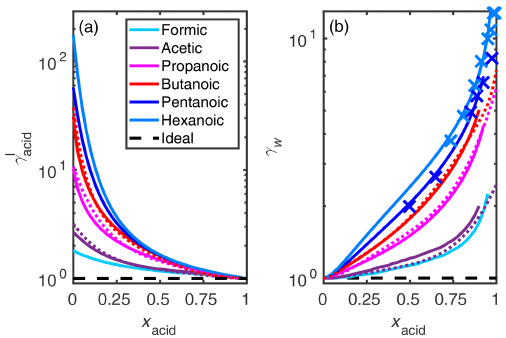
Figure 4. Activity coefficients ( γ I ) of (a) monocarboxylic acids and (b) water in all mixing states of the binary aqueous solutions, at 298.15K. The solid lines represent activity coefficient estimates us- ing COSMO-RS-DARE, dotted lines are calculated from the equa- tions fitted to experiments by Hansen et al. (1955), and the mark- ers are the experimental points from the same study. For the stud- ied acids with finite aqueous solubilities at 298.15K (pentanoic and hexanoic acid), water activity coefficients were measured using acid-rich solutions (Hansen et al., 1955). The water activity coeffi- cients at high x acid are not shown in the figure, because COSMO- RS-DARE overpredicts the experiments by several orders of mag- nitude. All activity coefficient values are given in Tables S3 and S4 of the